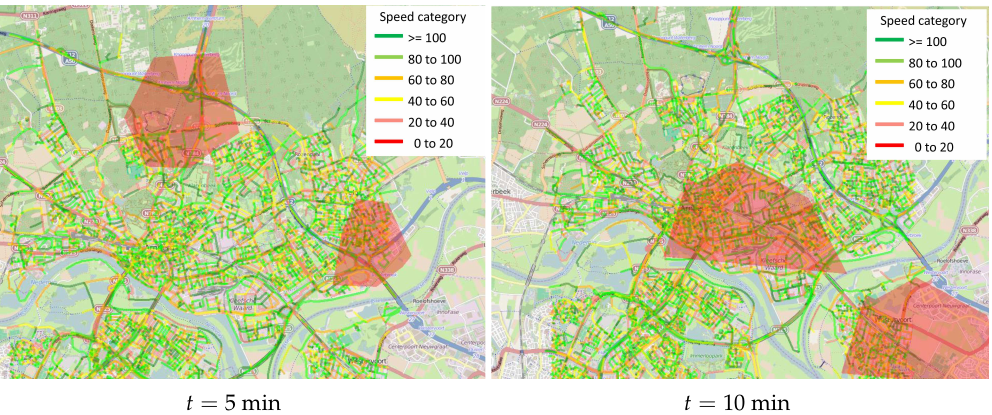
Figure 6. Snapshots of the movement of moving obstacles (in red polygons) and the traffic flows at different times.